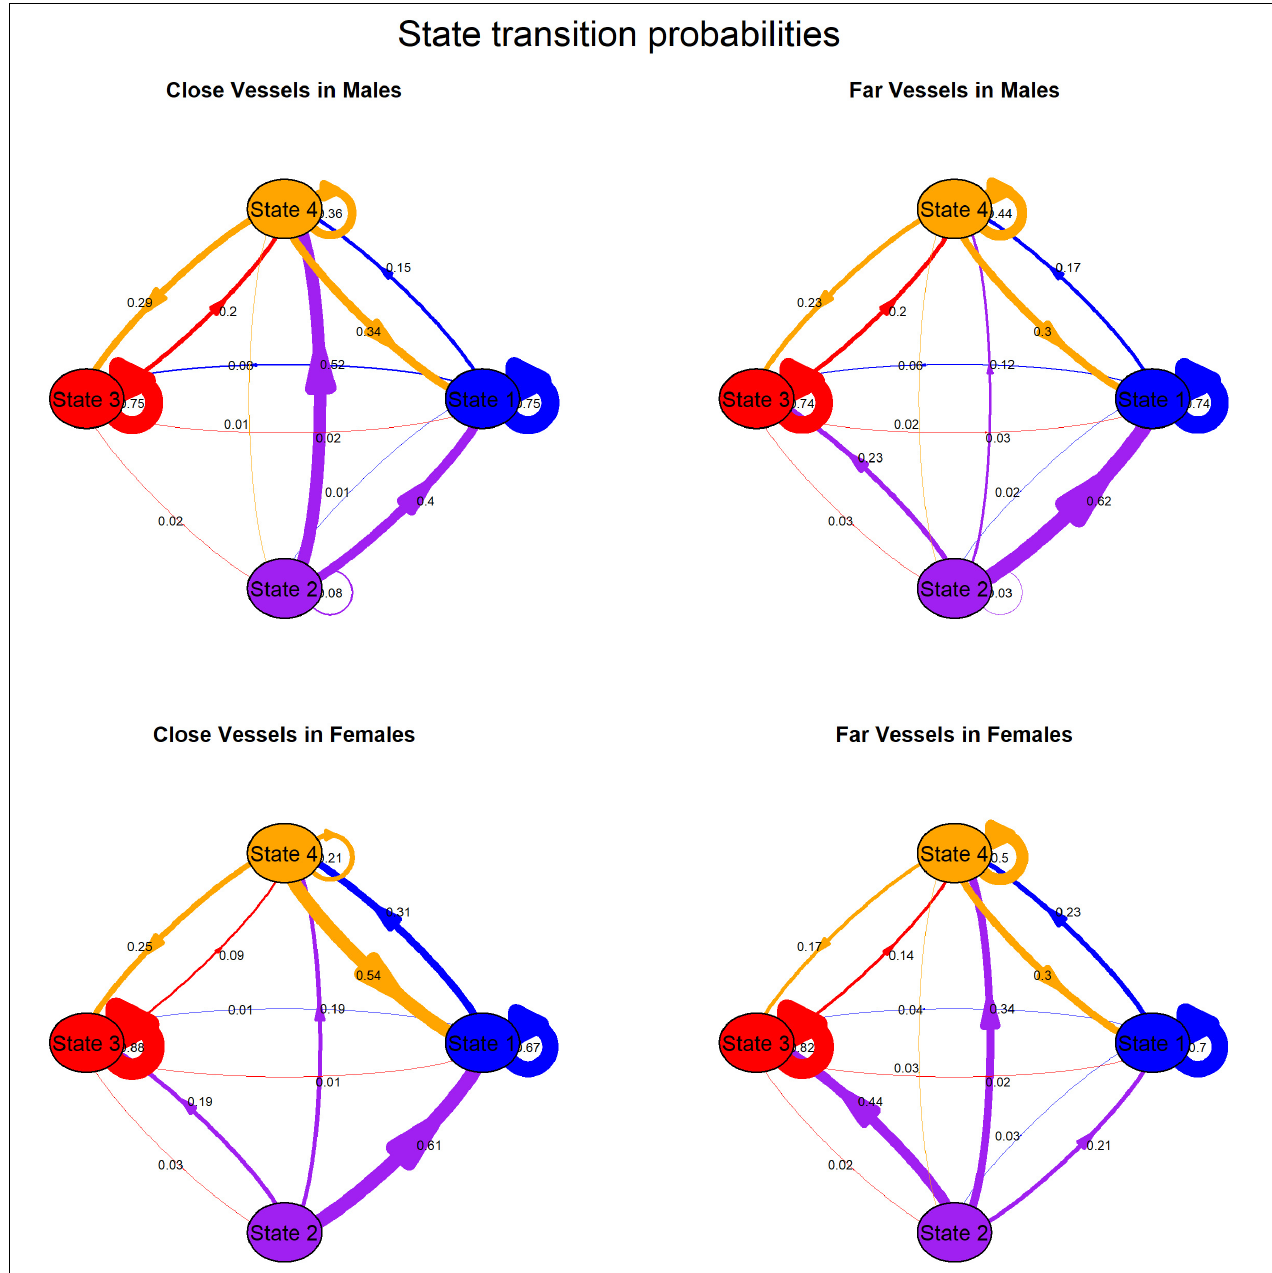
FIGURE 2 | Transition probabilities among states for males (top plots) and females (bottom plots) by close (left plots, mean vessel distance < 400 yd) and far (right plots, mean vessel distance ≥ 400 yd) vessels. Arrows indicate direction of transitions from state of origin, arrow thickness scales with probability. See Supplementary Table 1 for